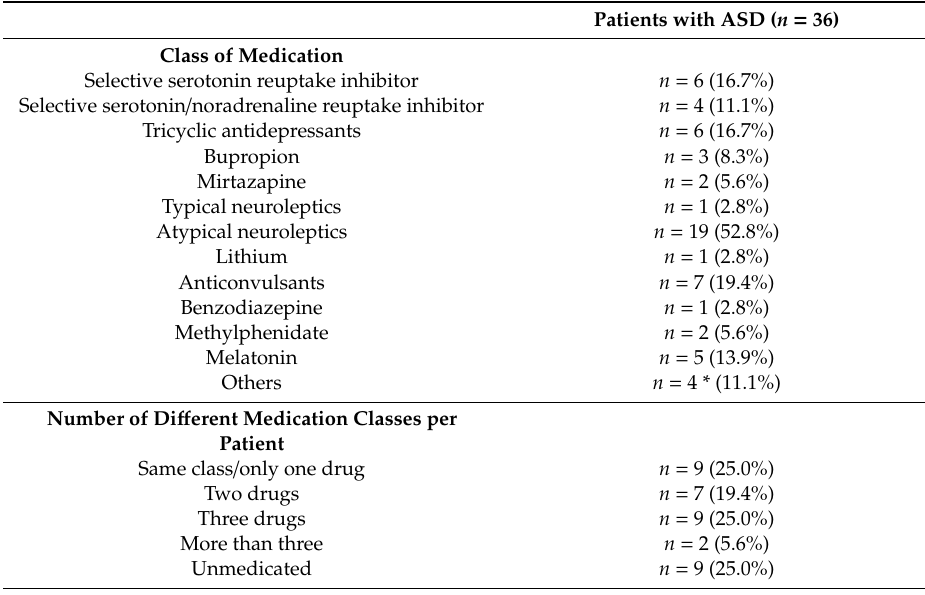
Table 2. Psychotropic medication at time of lumbar puncture.